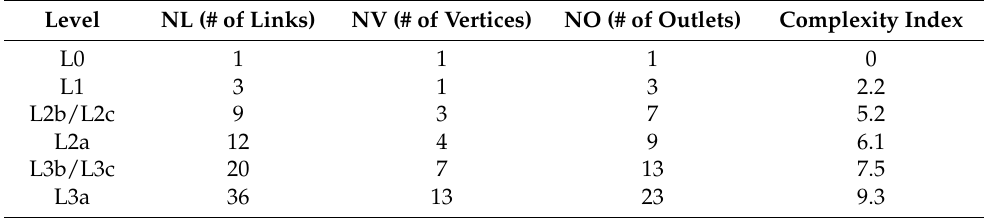
Table 1. Summary of the complexity index and topologic characteristics of each idealized deltaic system.